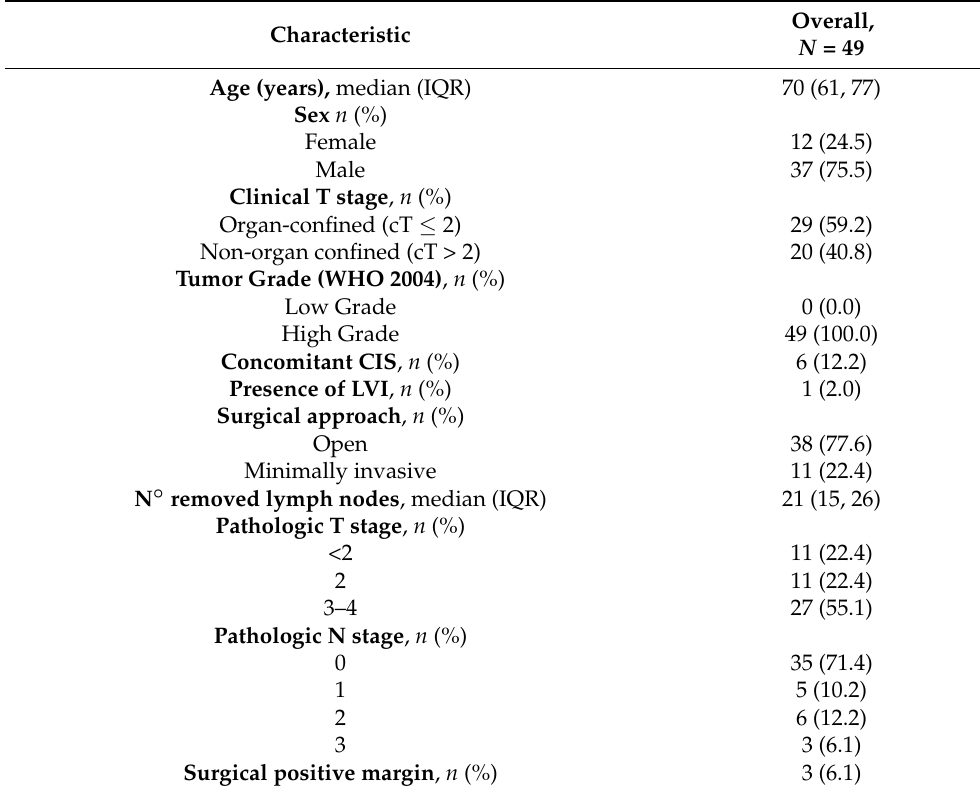
Table 1. Descriptive characteristics of 49 bladder cancer patients treated with radical cystectomy plus extended pelvic lymph-node dissection without preoperative systemic chemotherapy at our institution, from January 2019 to June